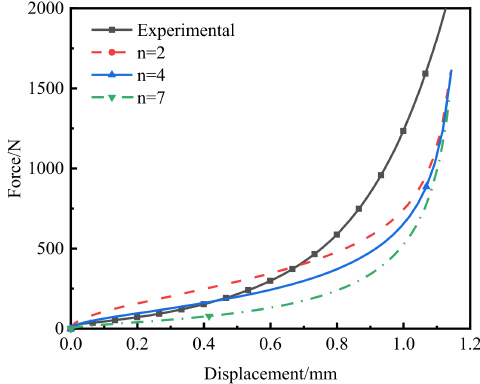
Figure 7. Calibration procedure of n value of flow stress model.